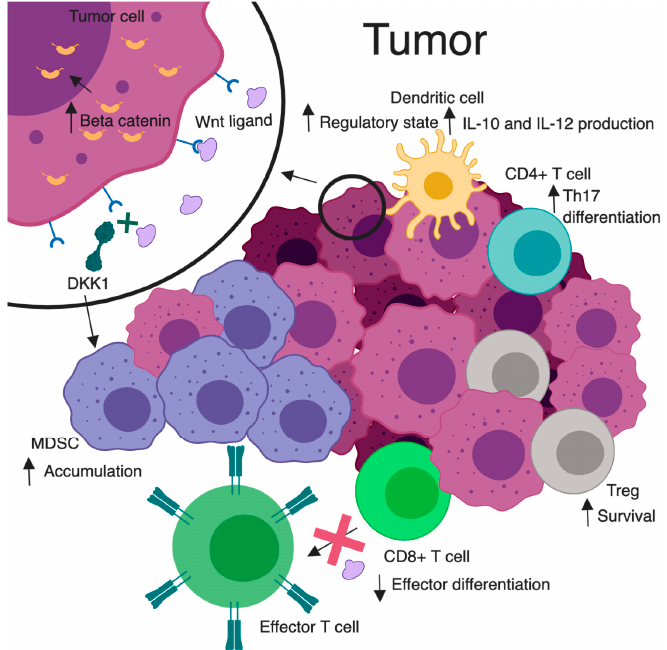
Figure 2. Wnt/ β -catenin signaling and tumor immunomodulation. A magnified tumor cell (top left), illustrates Wnt signaling leading to elevated cytosolic and nuclear β -catenin. Increased Wnt signaling is associated with heightened survival of Tregs, skewed differentiation of CD4 + T cells to a pro-tumorigenic Th17 subtype, conversion of dendritic cells to a regulatory state with enhanced IL-10 and IL-12 secretion, and decreased effector differentiation and function in CD8 + T cells. DKK1 inhibits Wnt ligand/receptor interactions. Elevated DKK1 leads to an accumulation of MDSC in the TME and subsequent inhibition of effector CD8 + T cell function. Created with BioRender.com. Not drawn to scale.